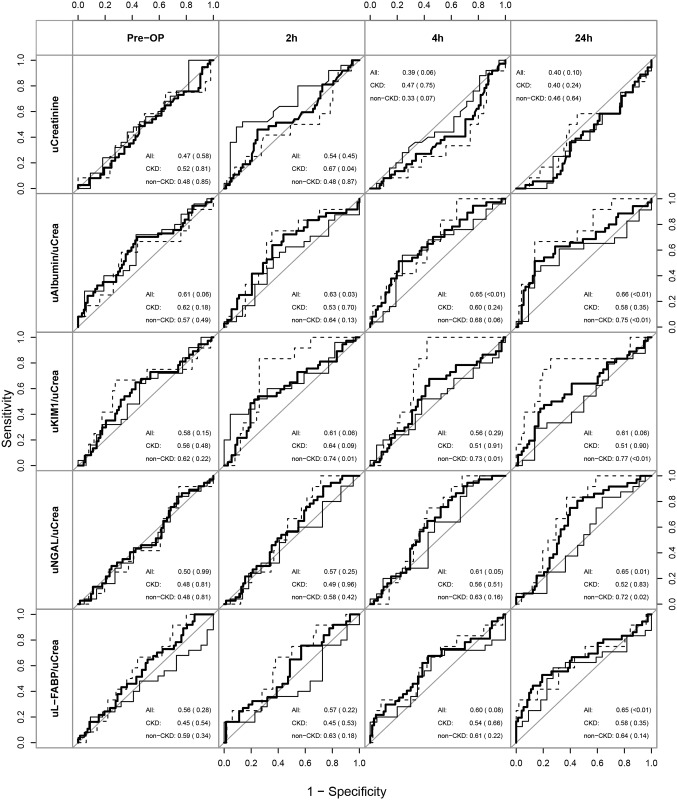
Diagnostic performance of biomarkers in urine.Receiver operating characteristic curves (AUC-ROC) show discriminative abilities for preoperative risk stratification (pre-OP) and postoperative diagnosis of AKI (at 2h, 4h and 24h after CPB) for all patients (solid thick line) and separately for patients with (sold thin line) and without (dashed line) preexisting CKD. Indicated are AUC (p-value).